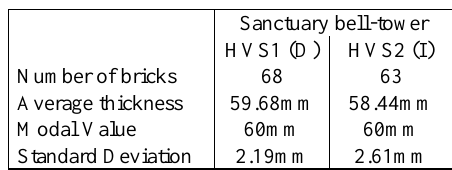
Table 2. Data evaluation from the Sanctuary